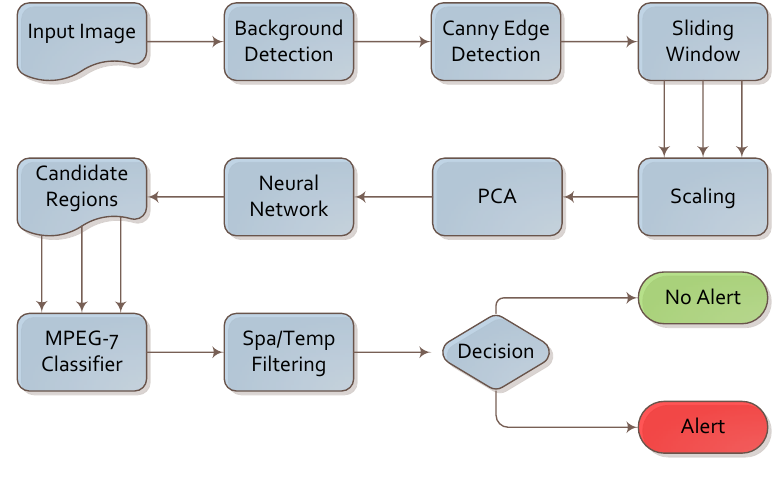
Figure 3. Algorithm for firearm detection.